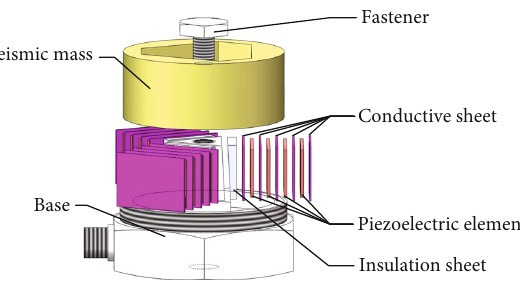
Figure 2: 3D view inside the shell of the sensor.